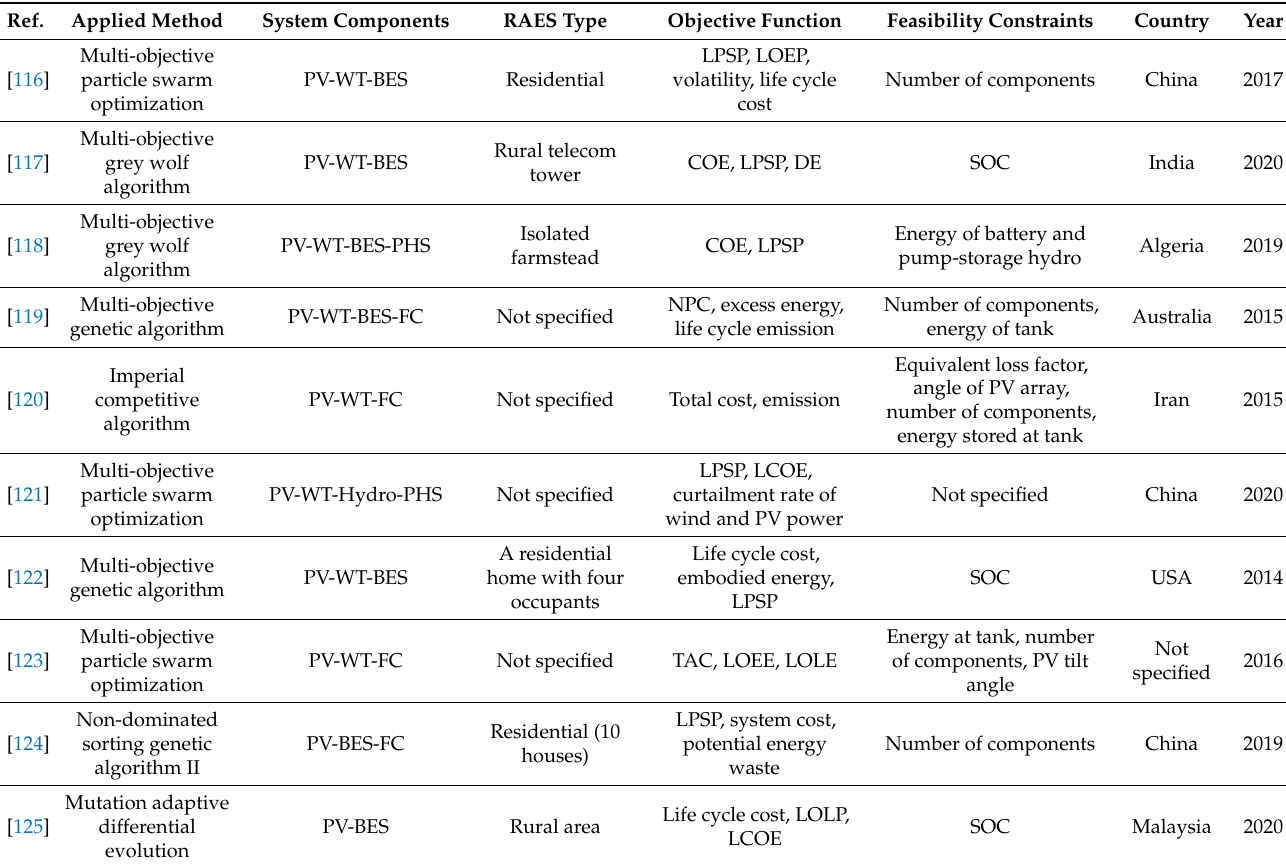
Table 8. Clean RAES systems optimal planning with multi-objective metaheuristic methods.